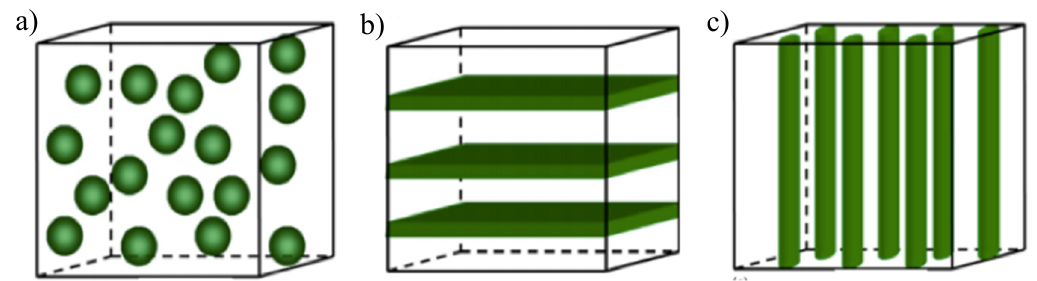
Figure 2. The schematic illustration of three bulk composites with different connectivity: ( a ) (0–3) particulate composite; ( b ) (2–2) laminate composite; ( c ) (1–3) fiber/rod composite. Reproduced with permission from [2] .